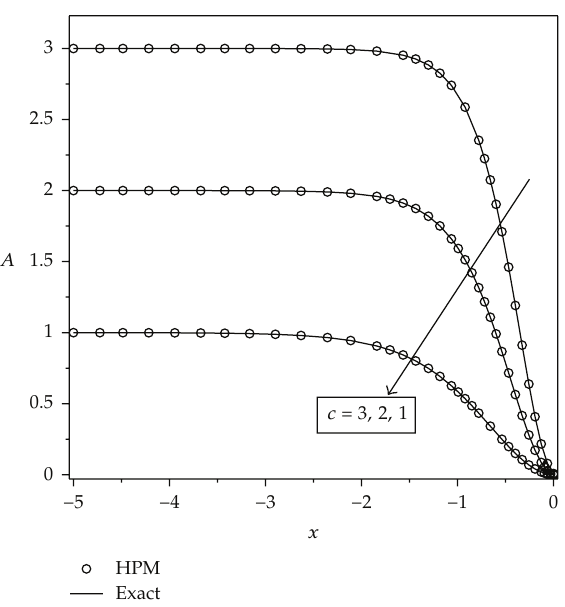
Figure 6: The e ff ect of c at t (cid:9) 0 .